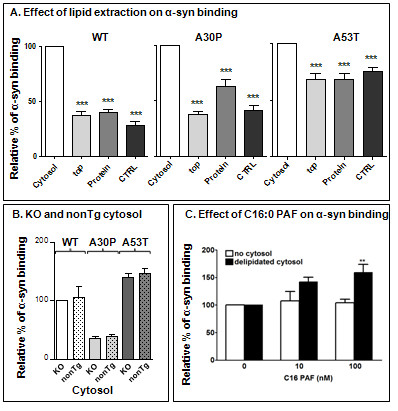
Effects of cytosolic lipid depletion on α-syn binding. (A) Using chloroform extraction to fractionate cytosol into three fractions: the top fraction contains the gangliosides or small organic polar molecules, the interface layer contains the proteins and the bottom phase contains lipids solubilised in chloroform. We incubated the synaptic membrane with the two lipid free-fractions, top and interphase (protein) layers, in presence of recombinant α-syn. The lipid-free fractions did not show any significant effects on the Wt and A53T α-syn binding compared to the control condition (α-syn incubated with synaptic membranes in absence of cytosol; Student T-test, p > 0.05) while the A30P α-syn binding was increased (compared to control condition, Student T-test, p < 0.01). (B) Recombinant α-syn (Wt, A30P and A53T) were incubated with synaptosomal membranes in the presence of 1.5 mg/ml cytosol from either KO mice (KO) or from non-transgenic mice (nonTg) for 10 min at 37°C. Binding of normal and mutant human α-syn, measured by the human α-syn specific monoclonal antibody 211, is normalized to that of Wt α-syn in the presence of KO cytosol. (C) Recombinant Wt α-syn was incubated with synaptosomal membranes and C16:0 PAF (0, 10, 100 nM) in the absence (open bars) or presence of delipidated cytosol (closed bars). Inclusion of 100 nM C16:0 PAF significantly increased α-syn binding only in the presence of the delipidated cytosol (compared to corresponding condition without C16:0 PAF, Two-Way ANOVA, p < 0.01, Bonferroni's multiple comparison test p < 0.01, n = 3).